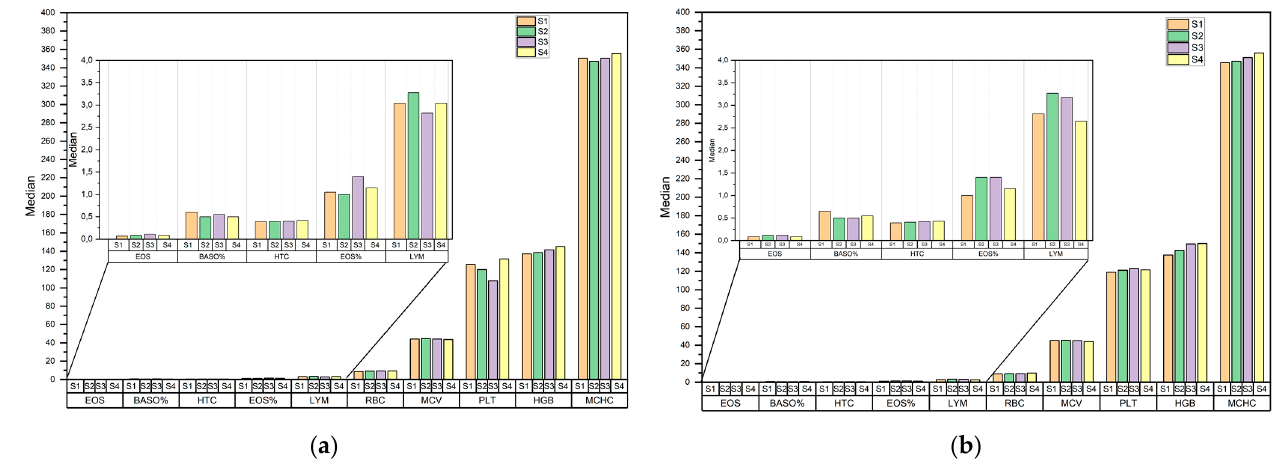
Figure 1. Hematological blood analysis median values for the: ( a ) supplemented group (G0); ( b ) control groups (G1); day 1 (S1), day28 (S2), day 56 (S3), day 84 (S4).